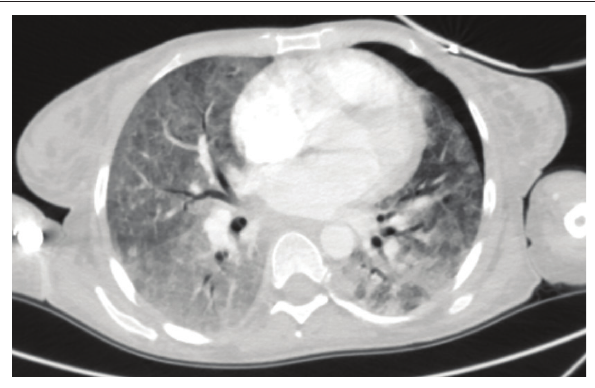
FIGURE 4 : Left pneumothorax, extensive ground-glass opacities and posterior consolidations in a patient with respiratory distress.